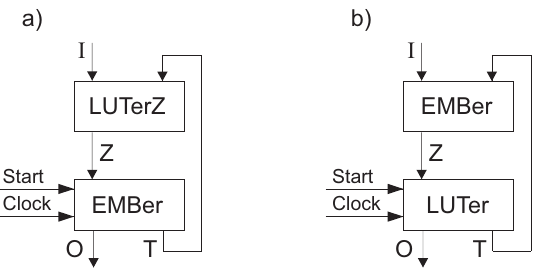
Figure 22. Structural diagrams of PH Mealy FSM with (cid:104) LUTer , EMBer (cid:105) ( a ) and (cid:104) EMBer , LUTer (cid:105) ( b ) organization.